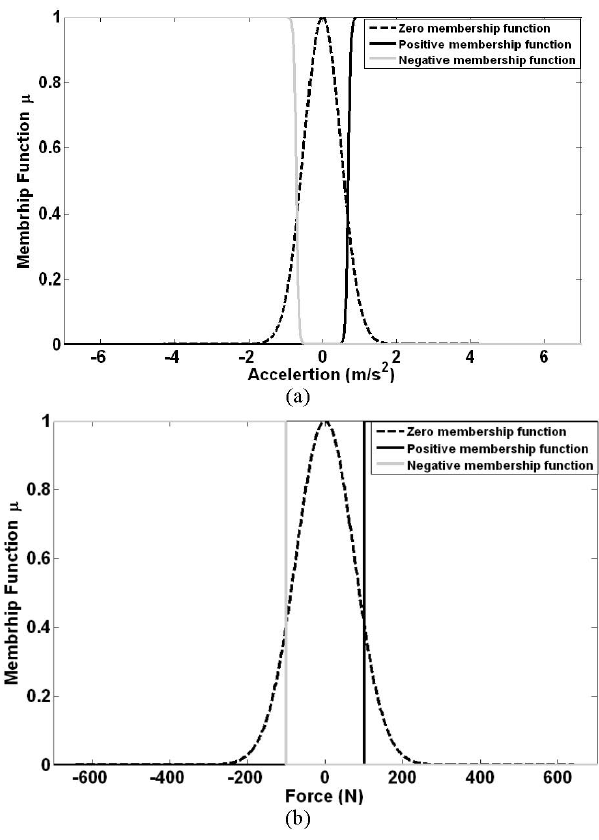
Figure 8. Linguistic variables for each channel (a) VBAE’s member- ship functions (b) AFE’s membership